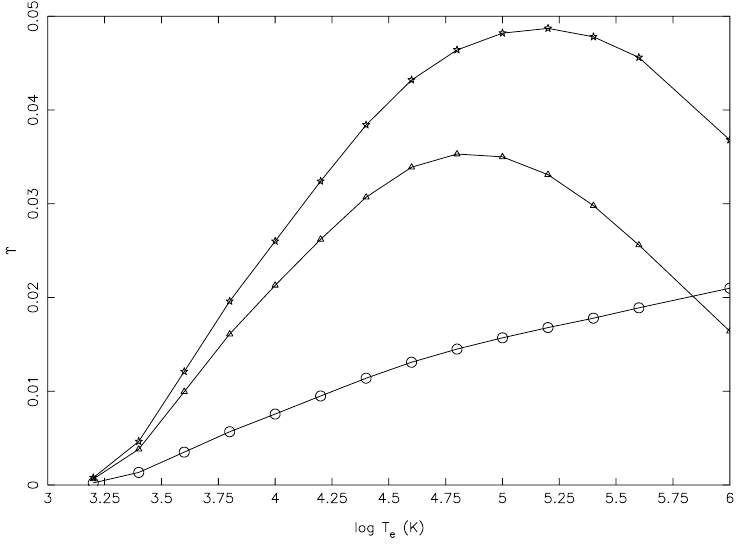
Figure 7. Effective collision strengths ( Υ ) of [27] for three forbidden transitions of Mg V. Circles: 19–86 (2p 3 3s 1 D o 51–86 (2p 3 ( 4 S)3d 3 D o